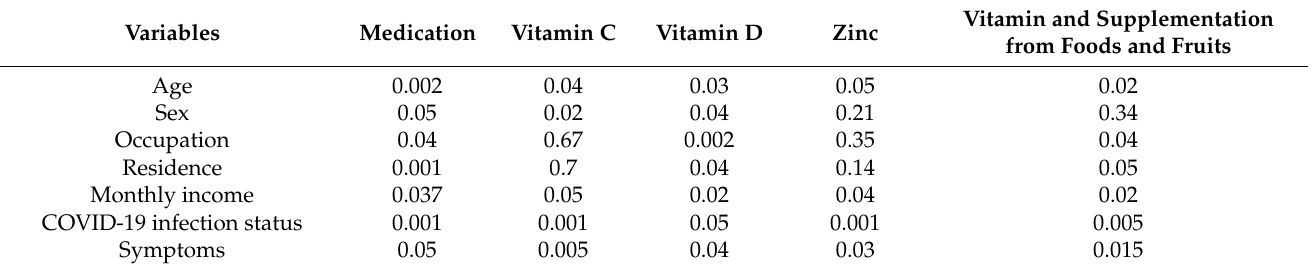
Table 3. Association of socio-demographic factors with the uptake of vitamins and supplementation.